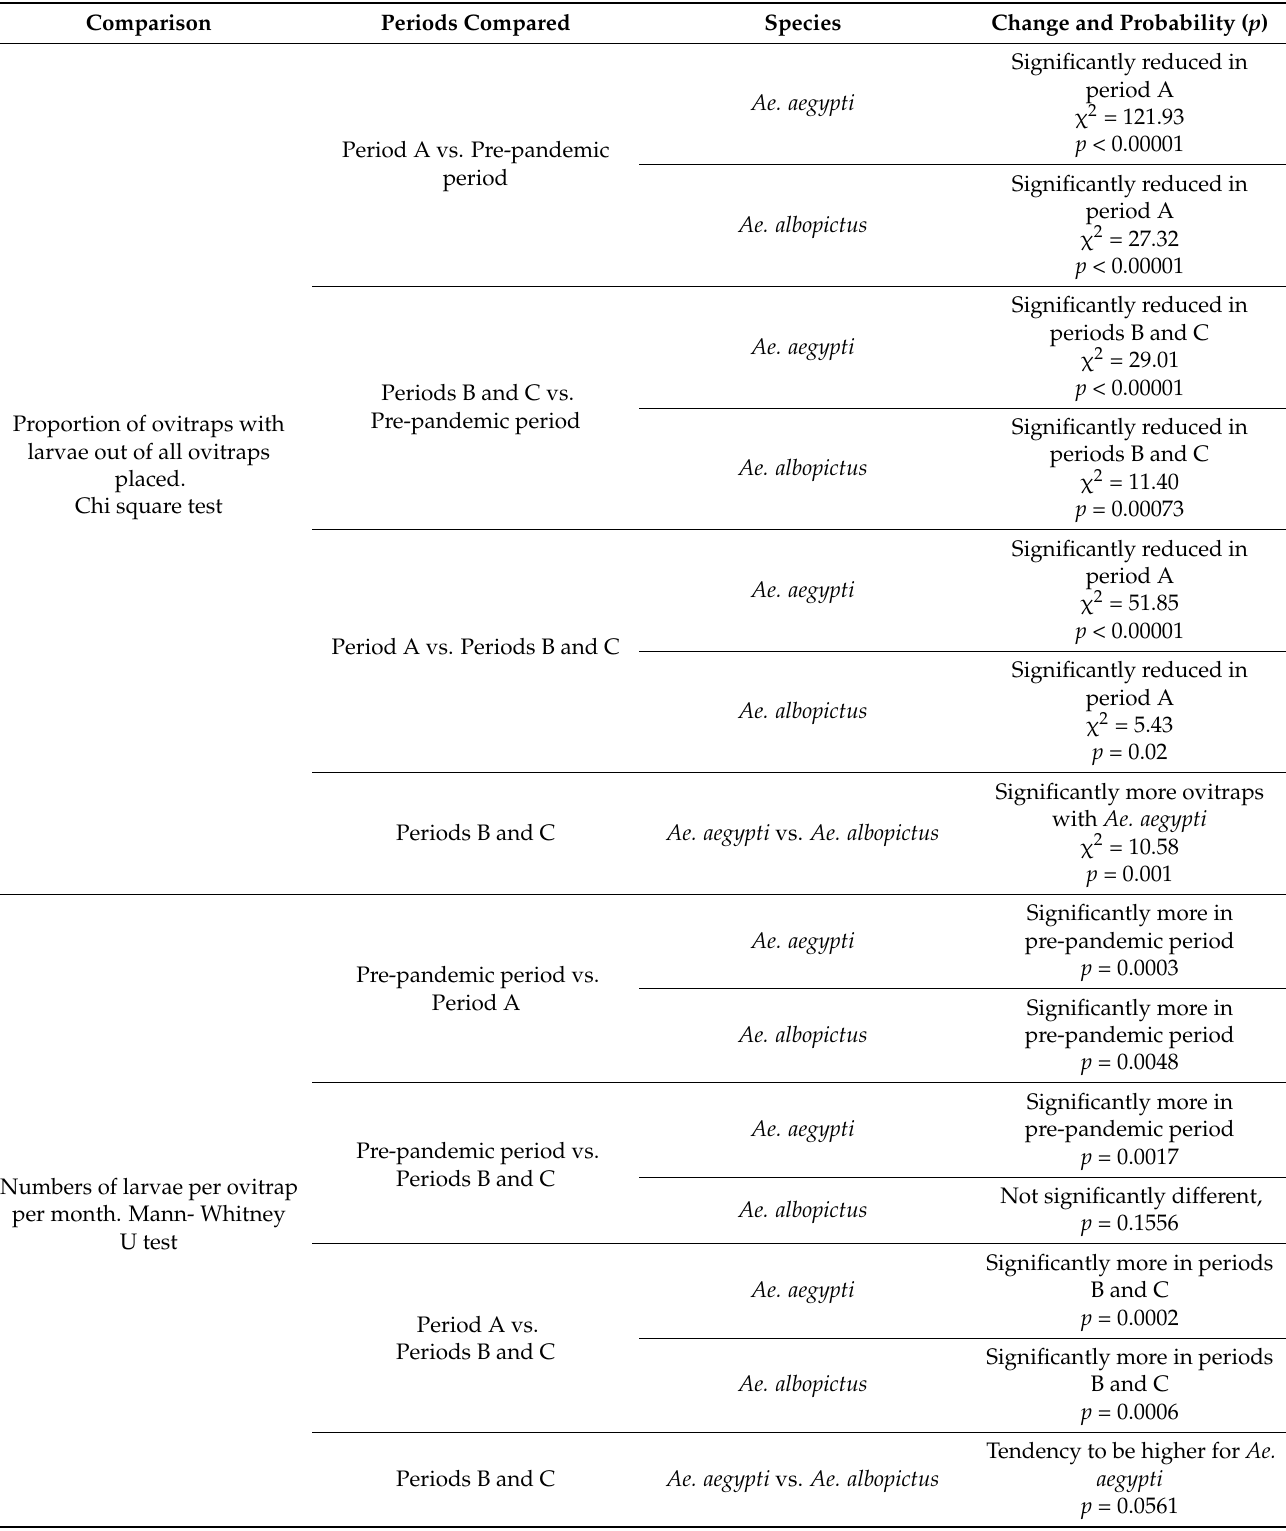
Table 2. Comparison of Aedes collections from ovitraps during different movement restriction periods shown in Table 1